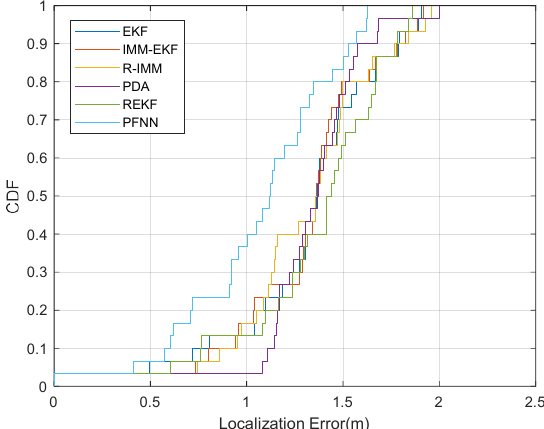
Figure 13. The CDF versus the localization error.